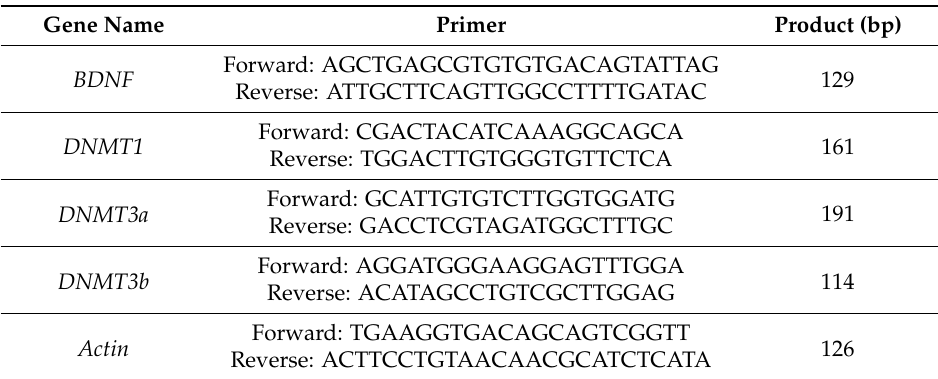
Table 1. Primer sequences for quantitative real-time